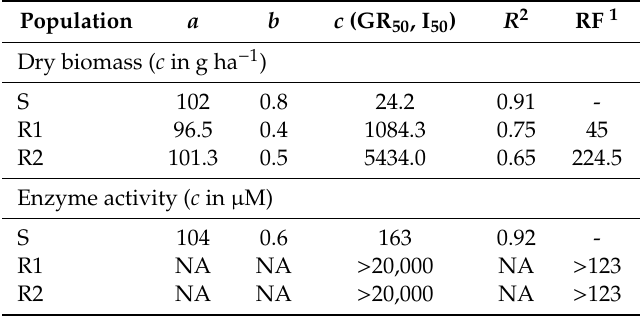
Table 1. Dose-response parameters and resistant factors (RF) for two imazamox-resistant wild poinsettia ( Euphorbia heterophylla ) populations based on dry biomass and enzyme activity.